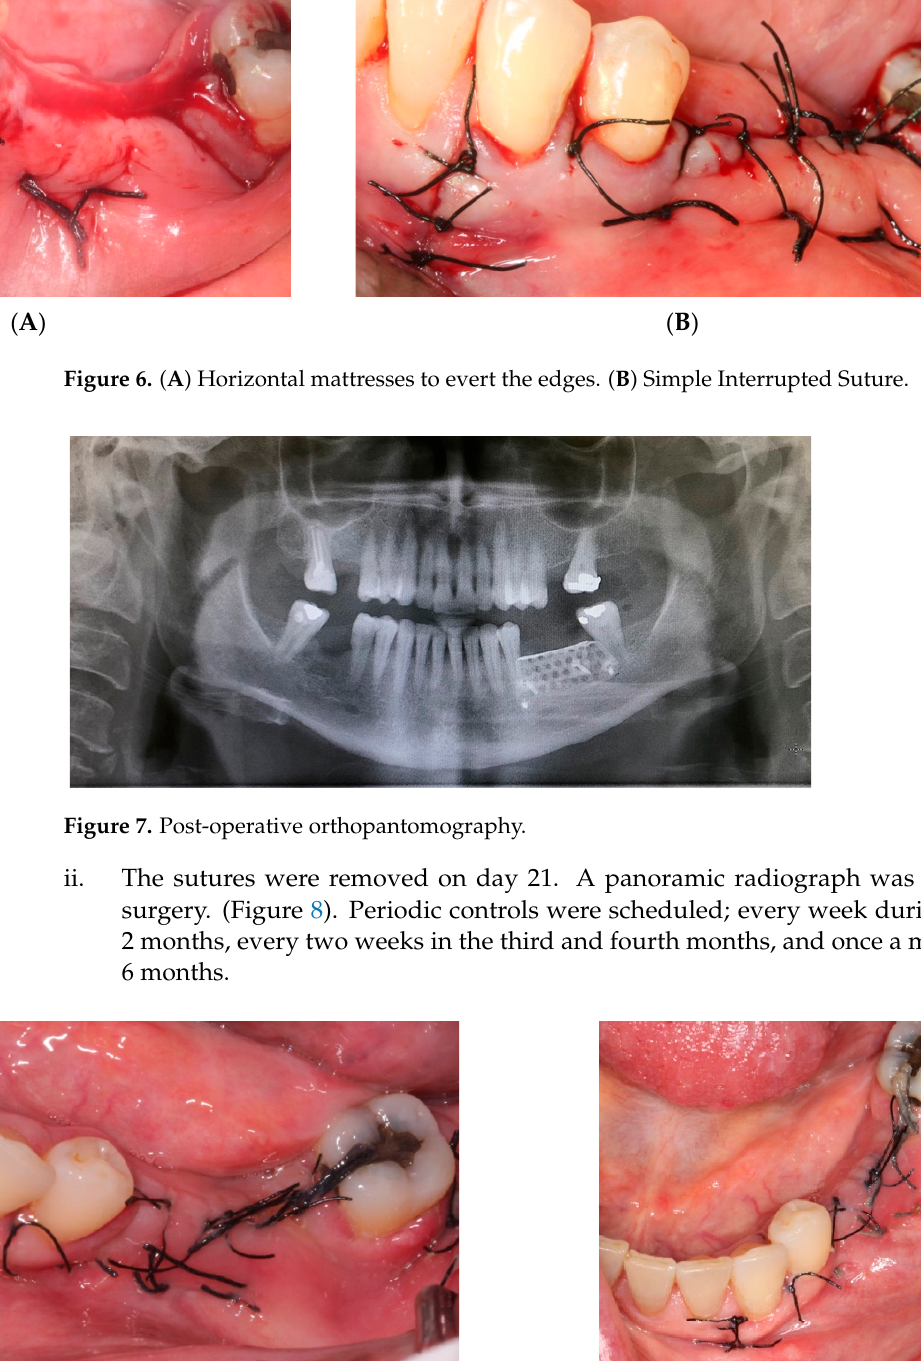
Figure 5. ( A , B ) Placement of the mesh with the biomaterial inside. ( C ) Placement of the collagen membrane outside the titanium mesh.